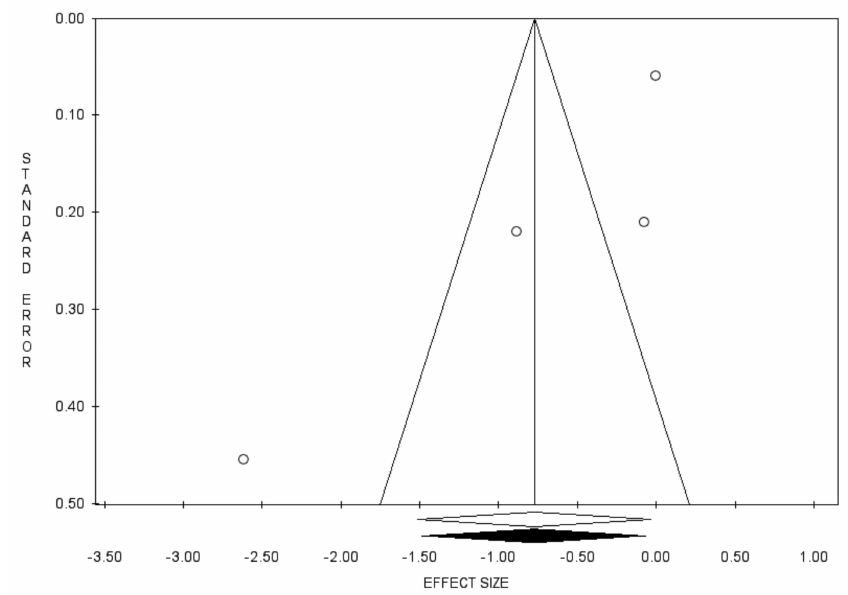
Figure 8. Funnel plots of the meta-analysis evaluating the association between use of 5-ARIs and the RR of BCa recurrence. Egger’s linear regression (t = − 2.39, p = 0.139) and Begg and Mazumdar rank correlation test (z = − 2.04, p =